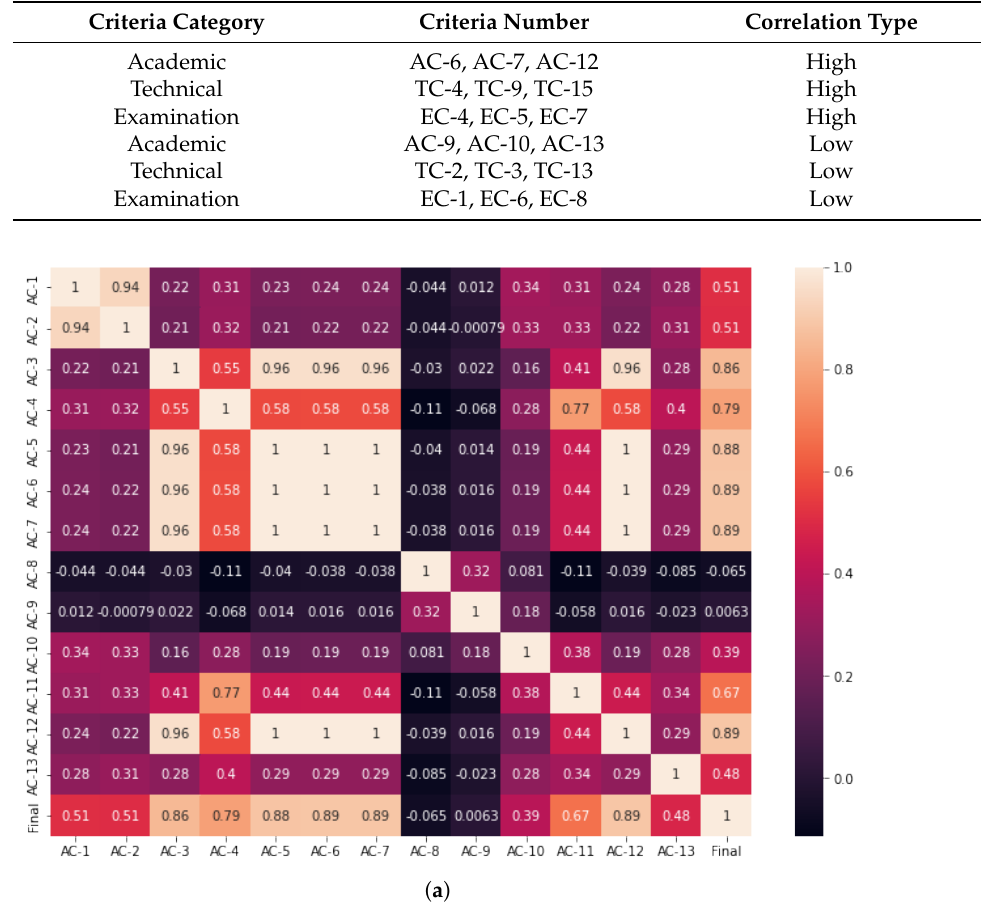
Table 6. Selected QTEF criteria.